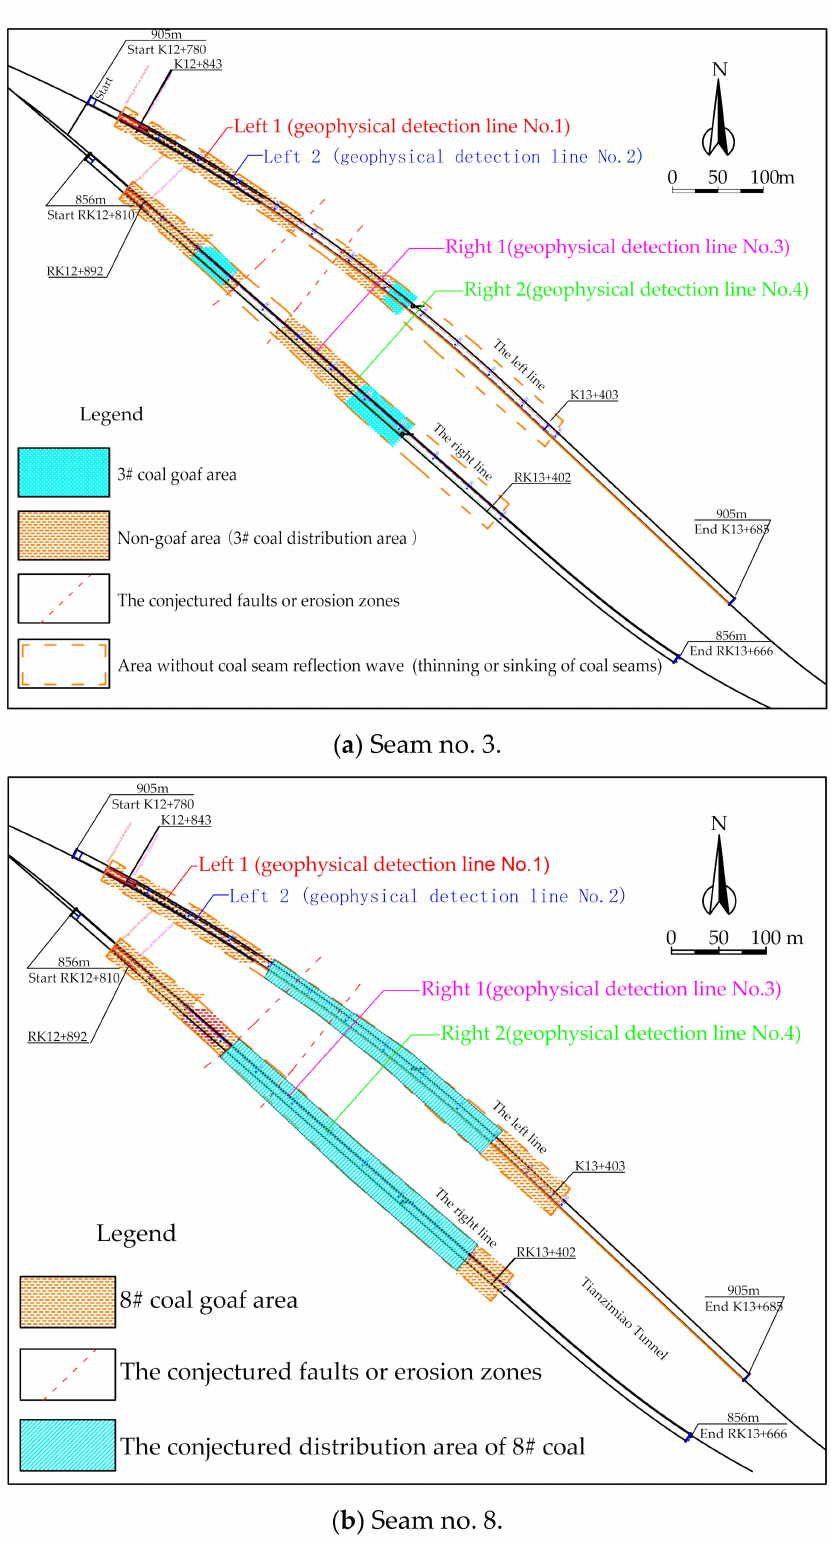
Figure 4. Distribution of the goaves beneath the Tianzimiao